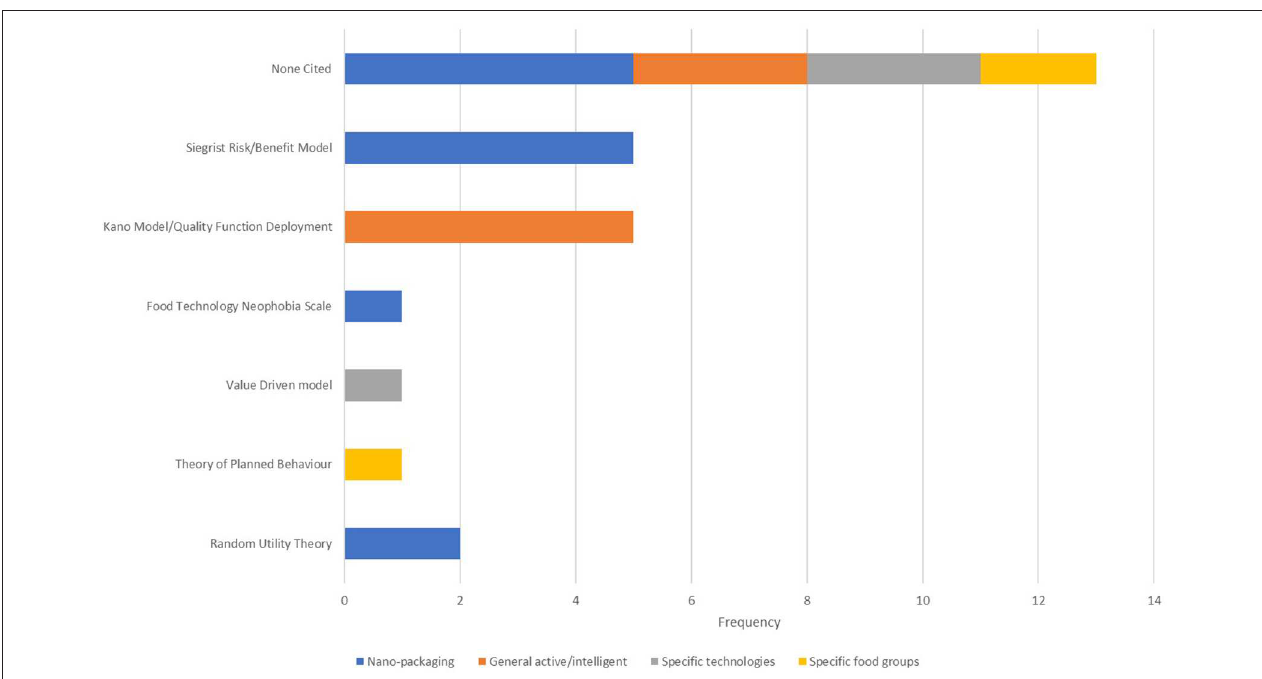
FIGURE 6 | Theories cited in eligible